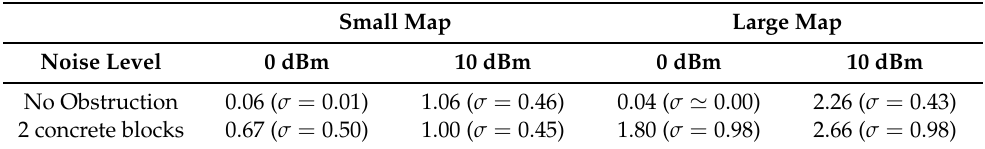
Table 2. Multilateration location prediction errors in meters.